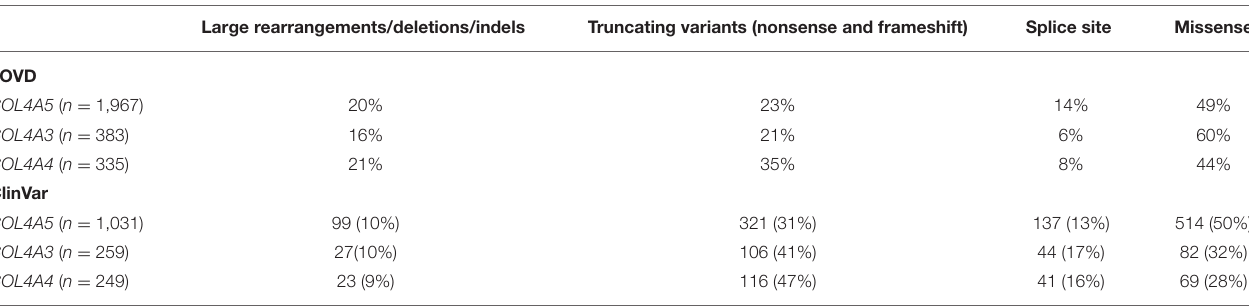
TABLE 1 | Types of all pathogenic variants in COL4A5, COL4A3, or COL4A4 . Large rearrangements/deletions/indels Truncating variants (nonsense and frameshift) Splice site